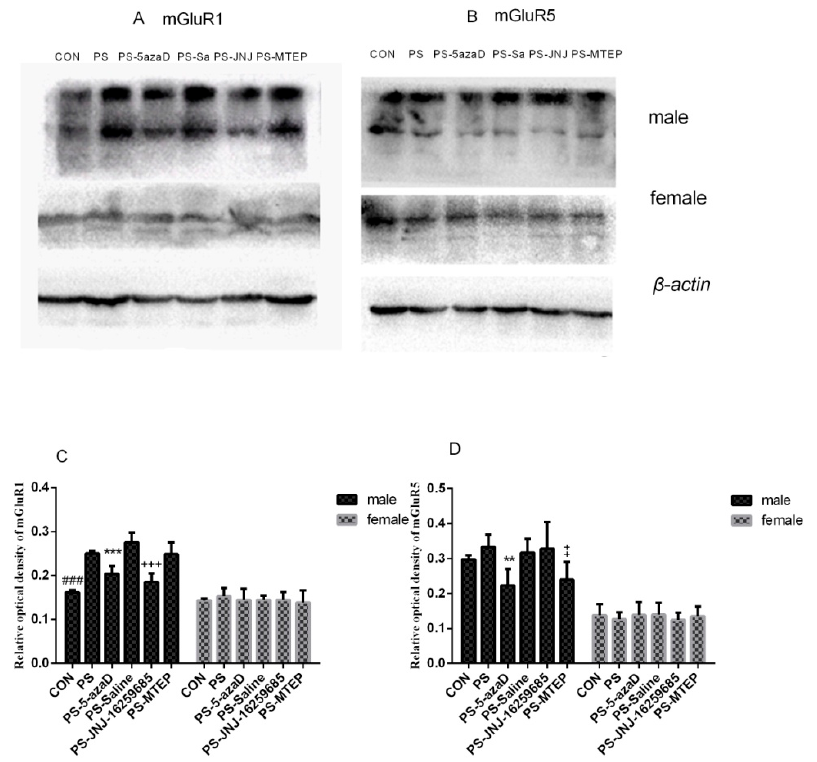
Figure 4. Western Blotting ( A ) MGluR1 changes in OR hippocampus revealed by Western blot; ( B ) MGluR5 changes in OR hippocampus revealed by Western blot; ( C , D ) Western blotting analysis of mGluR1 and mGluR5 protein levels in the hippocampus shown in six groups ( n = 6 each group). Data is expressed as mean ± SEM. ### p < 0.001 compare with CON. *** p < 0.001, ** p < 0.01, +++ p < 0.001, ++ p < 0.05 compare with PS.